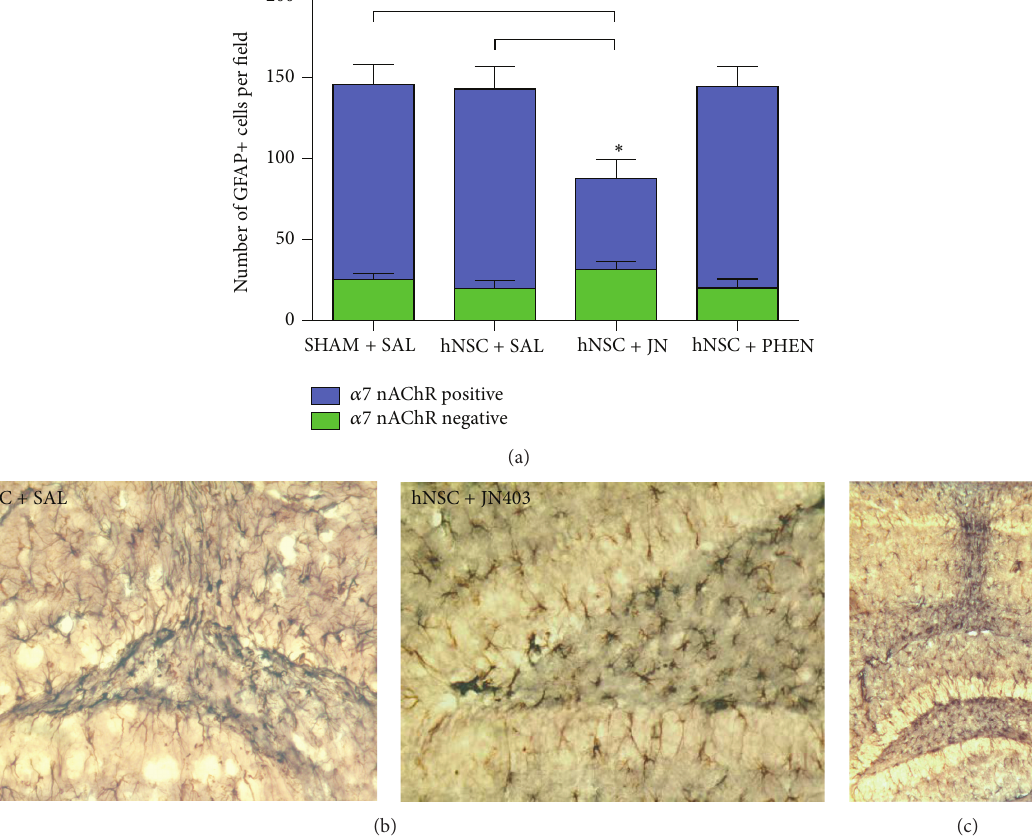
Figure 4: Treatment with the cholinergic 𝛼 7 nicotinic receptor agonist JN403 decreases the number of 𝛼 7 nicotinic receptor-expressing astrocytes in the dentate gyrus. (a) The number of 𝛼 7 nicotinic receptor/glial fibrillary acidic protein-positive (nAChR+/GFAP+) cells and the number of 𝛼 7 nAChR-negative/GFAP+ cells in the dentate gyrus of Tg2576 mice that received SHAM (vehicle) transplants and saline (SHAM + SAL) or hNSC transplants and saline (hNSC + SAL), JN403 (hNSC + JN), or (+)-phenserine (hNSC + PHEN). (b) Representative images of 𝛼 7 nAChR+/GFAP+ cells (black) and 𝛼 7 nAChR-negative/GFAP+ cells (brown) in hNSC + SAL and hNSC + JN mice. (c) Representative image of 𝛼 7 nAChR+/GFAP+ cells (black) in the needle track after hippocampal injection. ∗ 𝑝 < 0.05 compared to SHAM + SAL. The data are expressed as means ±